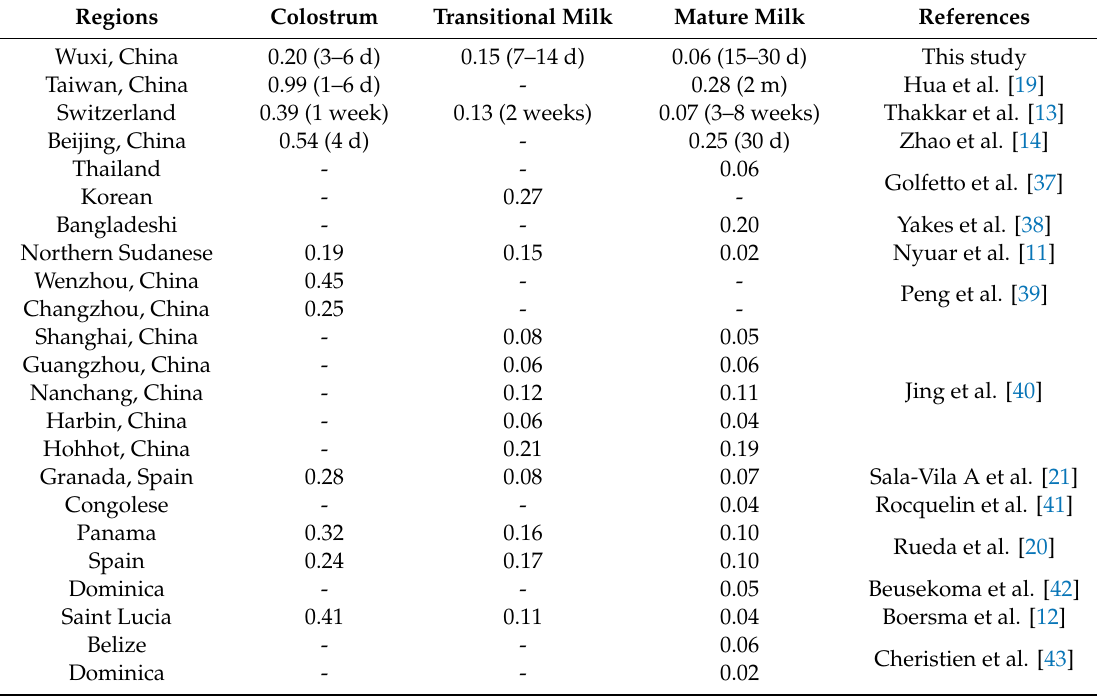
Table 2. Mean value of nervonic acid (wt%) in human milk from individuals in di ff erent regions.